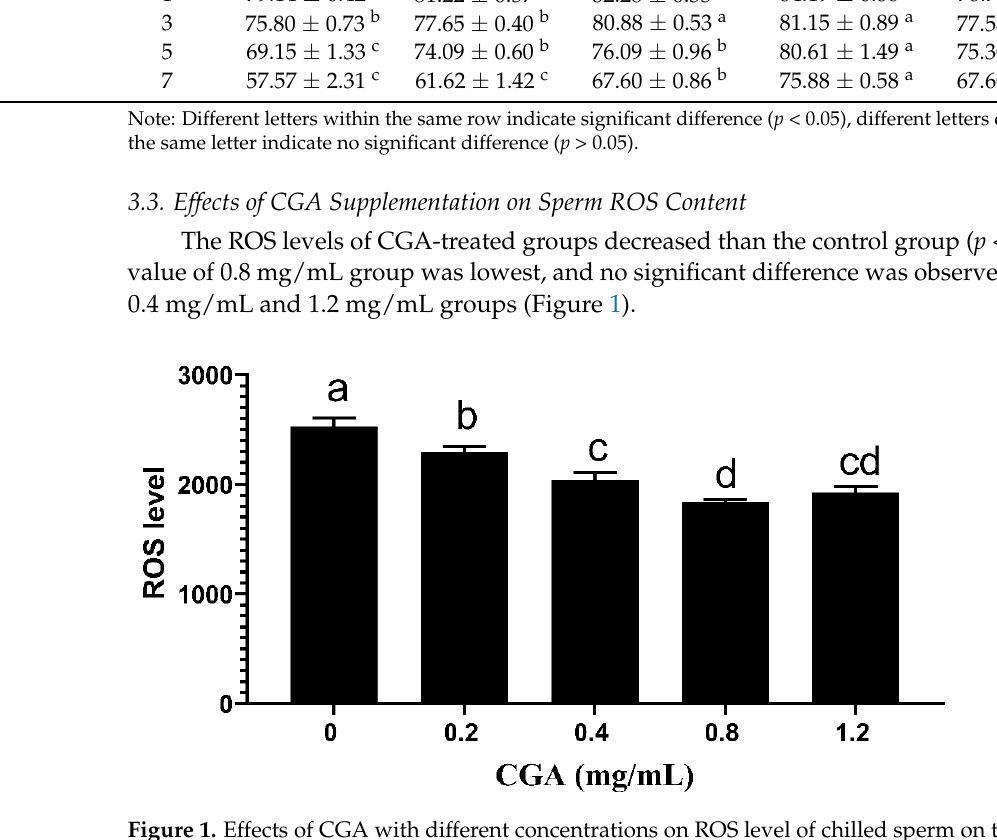
Figure 2. Effects of CGA with different concentrations on CAT activity of chilled ram semen. Note: Different letters above the column indicate significant difference, the same or containing the same letter indicate insignificant difference. 3.5. Effects of CGA on T-AOC in Seminal Plasma Compared with the control group, T-AOC of CGA added groups was higher ( p < 0.05), 0.8 mg/mL group was the highest from day 1 to 5. No significant difference was observed between o.4 mg/mL and 1.2 mg/mL group on the fifth day (Figure 3).